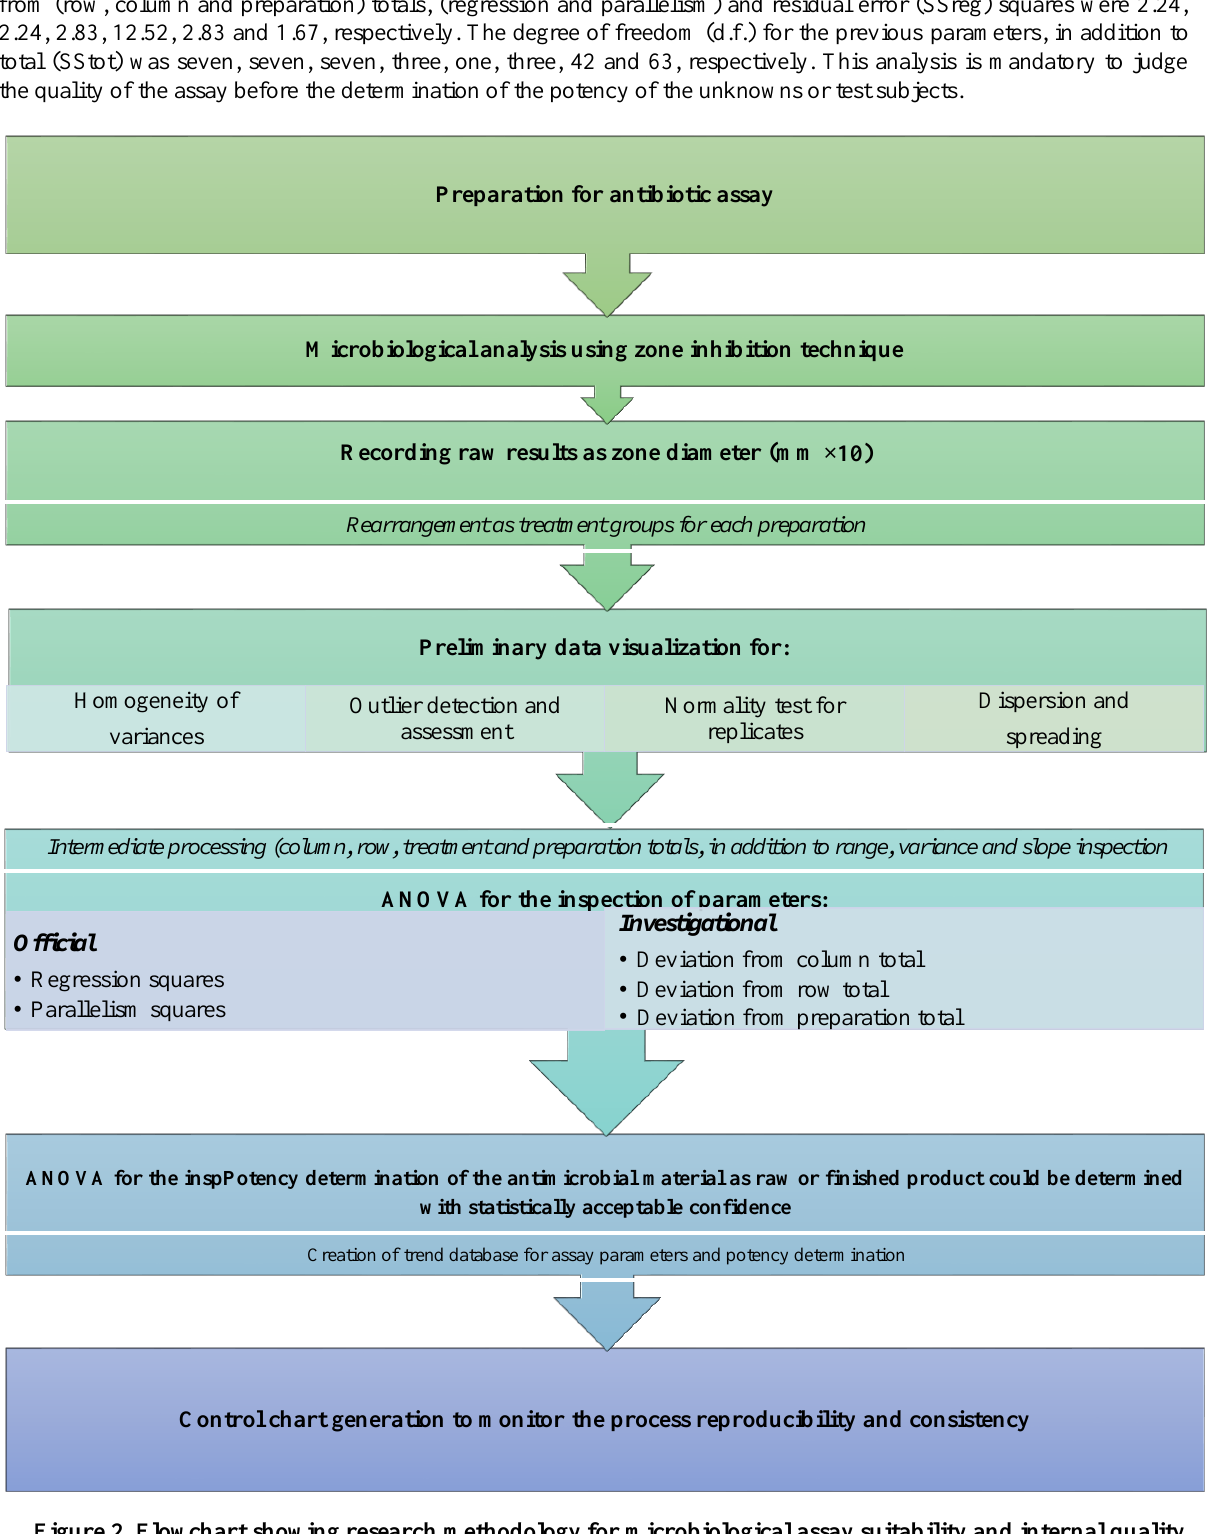
Figure 2. Flowchart showing research methodology for microbiological assay suitability and internal